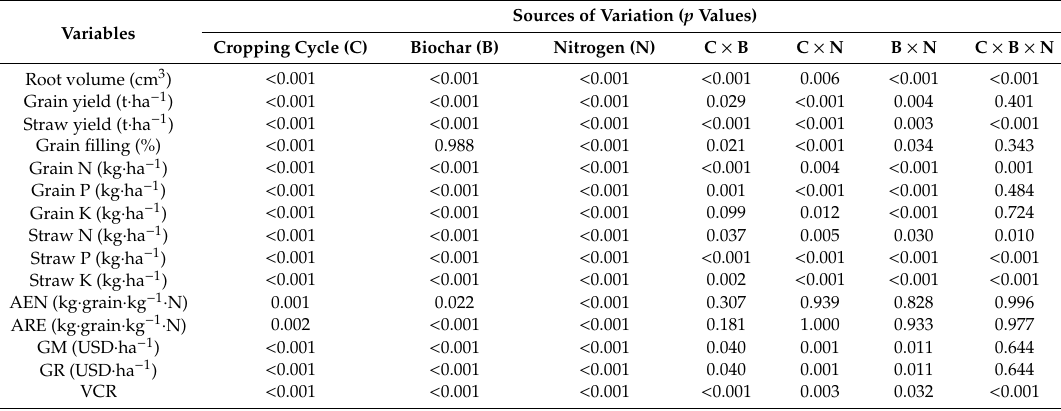
Table 4. Summary of the mixed-model repeated measures analysis of variance on all variables (yield, nutrient uptake, nutrient use and economic indicators) over the four cropping cycles.